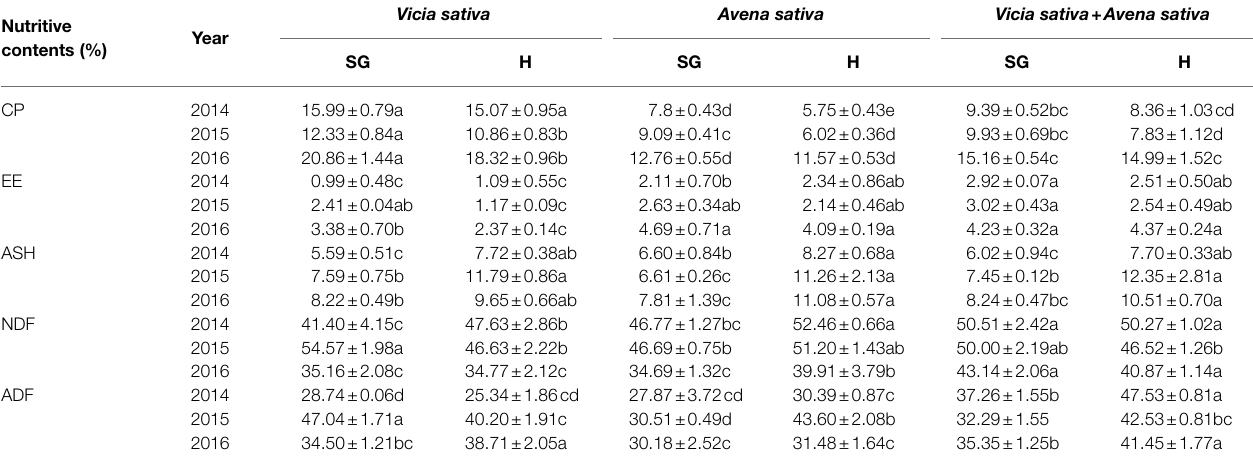
TABLE 1 | Response of different forage crop cultivation methods to forage varieties under different use patterns in 2014–2016 ( Vicia sativa , Avena sativa or Vicia sativa + Avena sativa ). Nutritive contents